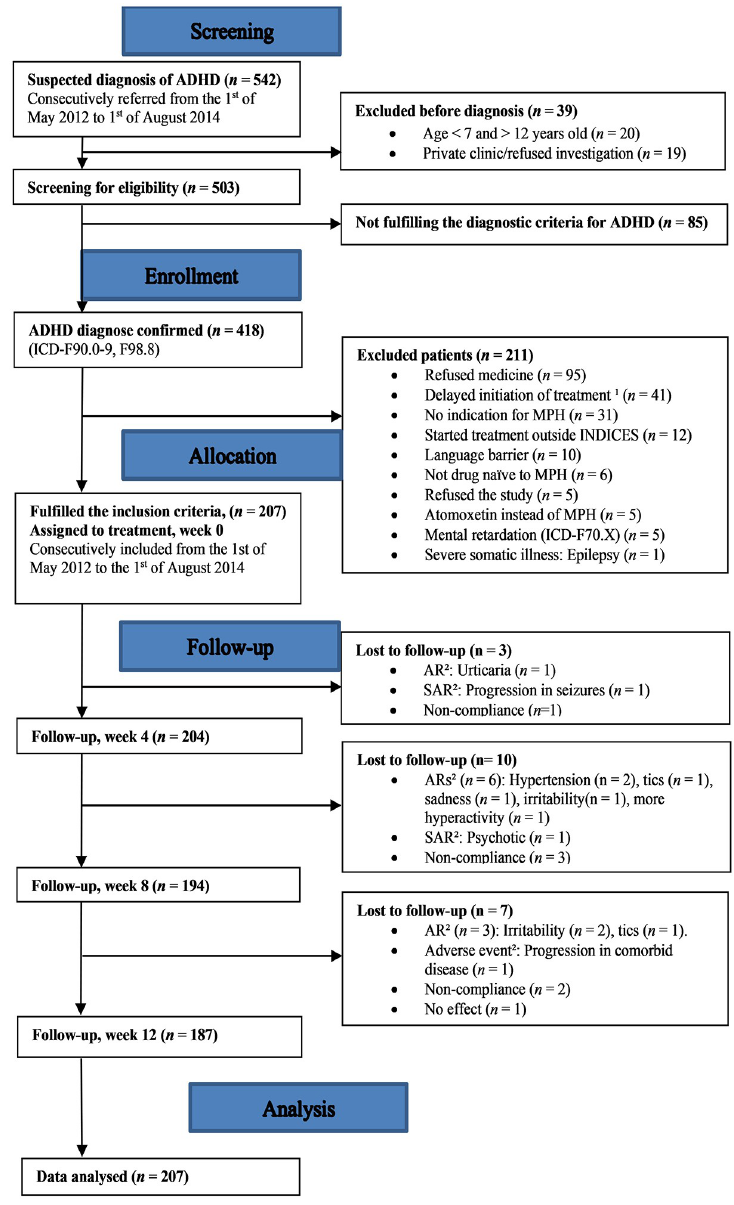
Fig 1. TREND, flow diagram of inclusion. ICD-10 = International Classification of Diseases and Related Health Problems, ADHD = Attention-deficit/hyperactivity disorder, MPH = Methylphenidate, INDICES = INDIvidualised drug therapy based on pharmacogenetics: focus on carboxylesterase 1, AR = Adverse reaction, SAR = Serious adverse reaction. 1 = Treatment initiated after the study inclusion period was terminated. 2 = Clinician decision of patient’s discontinuation of treatment with MPH due to adverse events, ARs, and